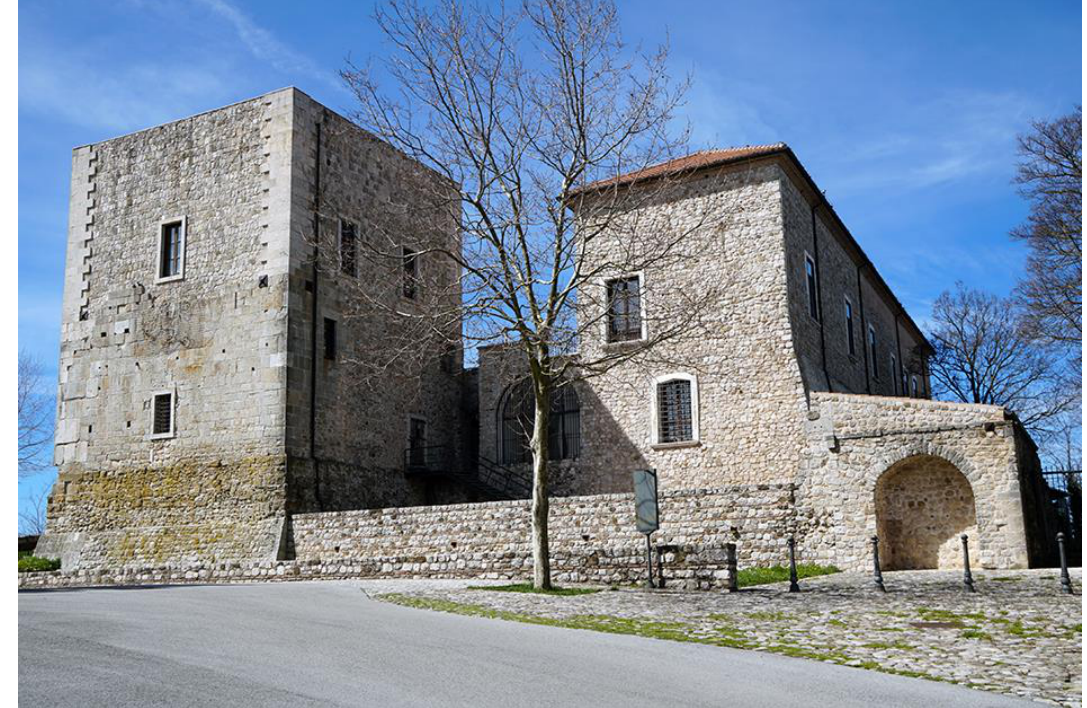
Figure 38. Sant’Angelo dei Lombardi: Castle of the Imperials of Sant’Angelo dei Lombardi in the Historical center (photos by [35,36]).